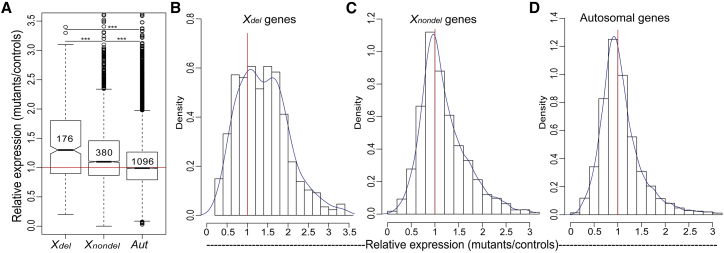
Relative Expression of X-Linked and Autosomal Genes in Leaves of Mutants Compared to ControlsThe X-linked genes are split into two categories: the genes for which Y-linked gametologs were deleted (Xdel) and not deleted (Xnondel) in the deletion mutants.(A) Significant upregulation of X-linked genes in the mutants compared to controls is evident in both categories of X-linked genes, though it is much stronger in the Xdel compared to Xnondel genes. The numbers of genes analyzed in each category are shown within the boxplot. The difference between gene categories was tested for significance with the Wilcoxon rank sum test, ∗∗∗p < 0.001. In the box-and-whisker plot (A), the box spans the first quartile (Q1) to the third quartile (Q3); the line inside the box shows the median; the notches represent the 95% confidence interval for the median; and whiskers show the range between Q1 − 1.5 × (Q3 − Q1) and Q3 + 1.5 × (Q3 − Q1).(B–D) Distributions of expression change in the mutants compared to controls for Xdel genes (B), Xnondel genes (C), and autosomal genes (D). The curves in (B) to (D) show the kernel-smoothed density function. The red lines at 1 in all panels show the null expectation for no difference in expression between deletion mutants and controls.Data used for this figure are listed in Data S1. See also Figure S1.